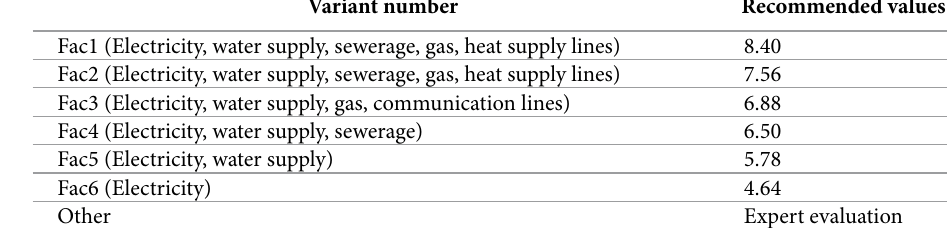
Table 4. Determinated weight values of integrated facilities variants Variant number